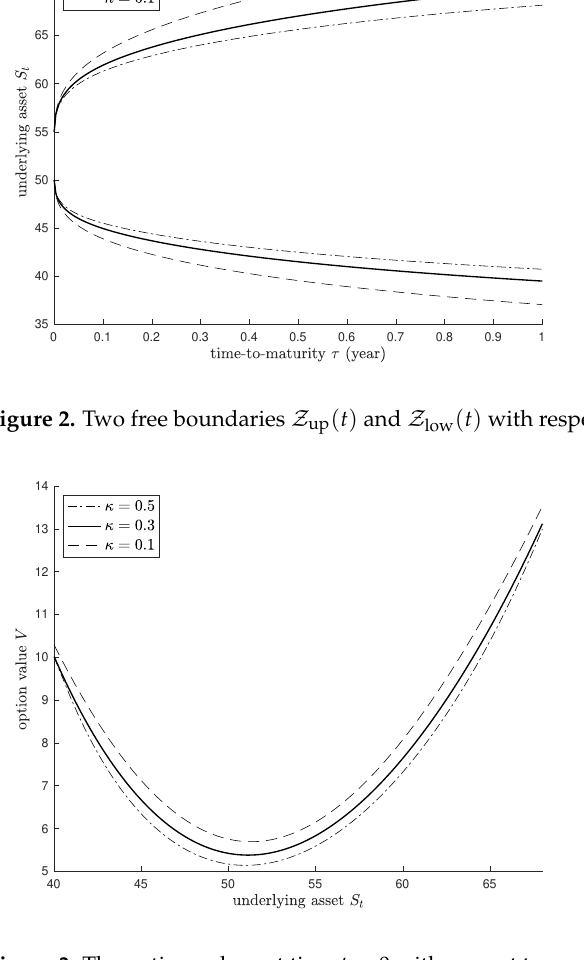
Figure 3. The option values at time t = 0 with respect to κ .